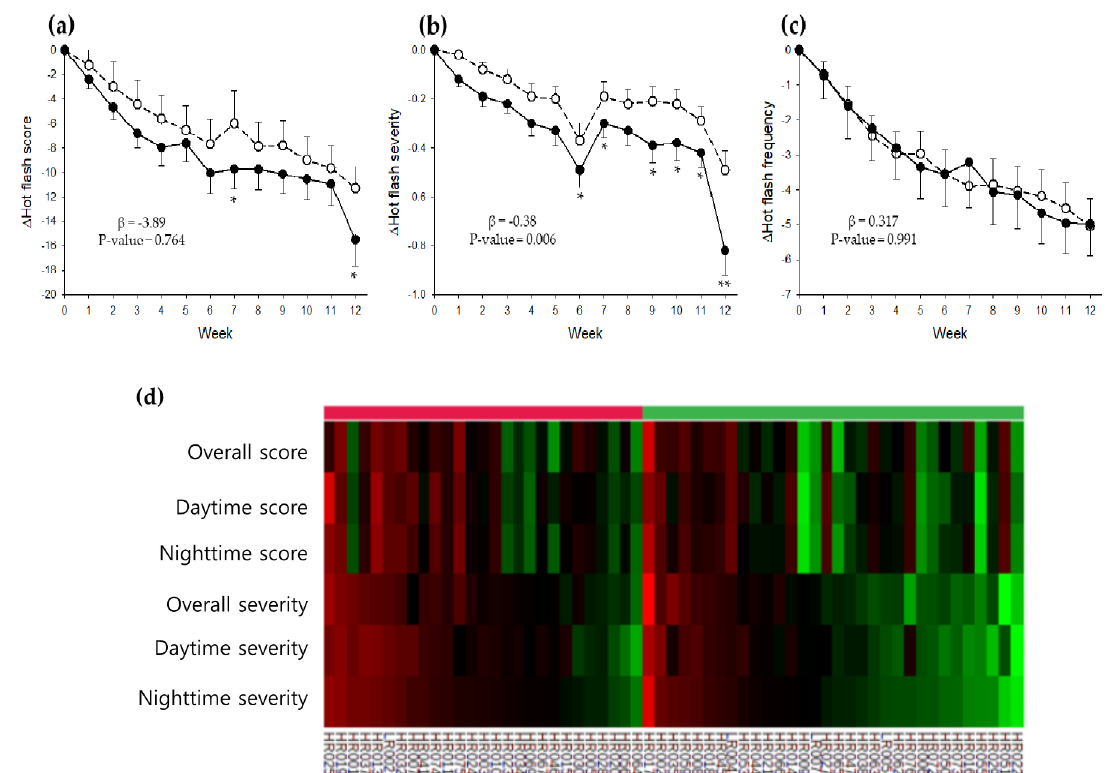
Figure 2. Changes in mean HF score ( a ), severity ( b ), and frequency ( c ) from baseline over the 12-week study period. Dots are experimental points (KM: black circles, placebo: empty circles). Heat map representing the changes in HF score and severity from baseline to the end of week 12 ( d ). The HF scores were calculated by multiplying the frequency experienced at that severity level. Then, the resulting points were summed to give a total daily score. Each daily score was averaged per week. Each value represents the mean + SE. Each column of the map represents one subject with all data for HF score and severity at total, daytime, and night-time in the heatmap. KM, an extract mixture of kudzu flower and mandarin peel; HF, hot flash. The p -values were obtained from a linear mixed-e ff ect model adjusted for covariates. * p < 0.05, ** p < 0.001.